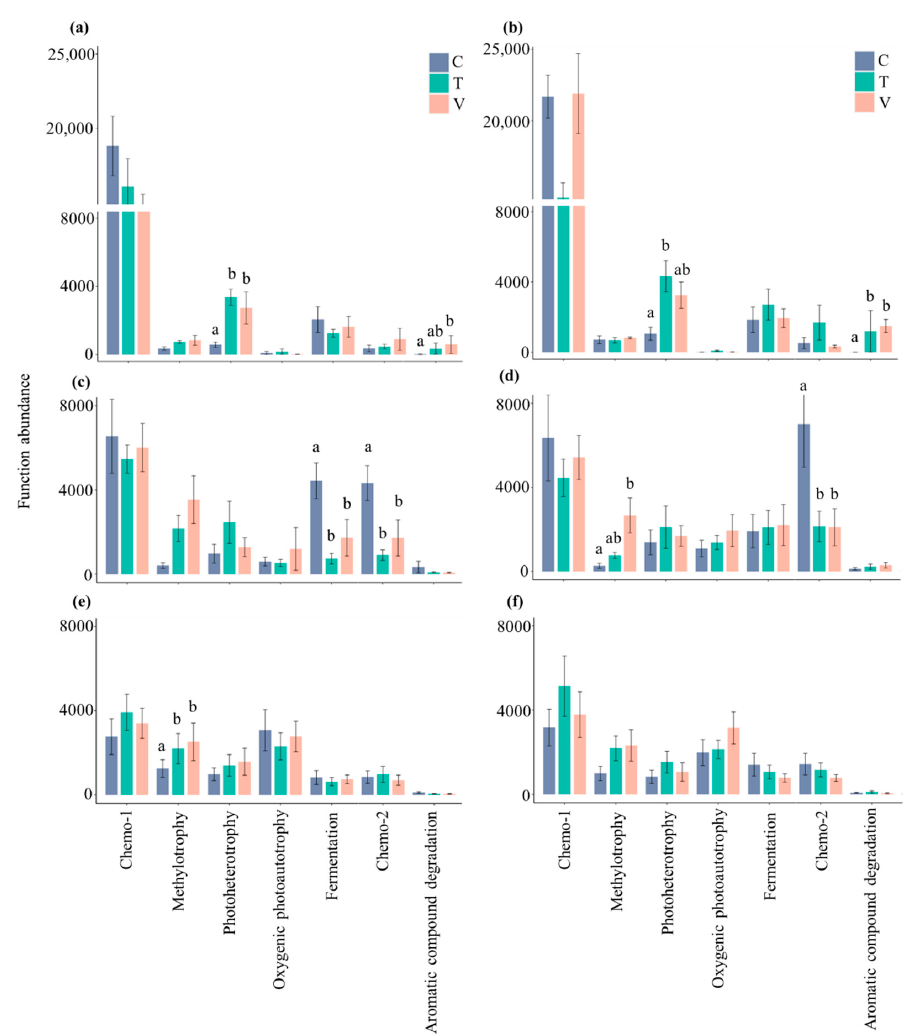
Figure 4. The columnar difference in bacterial functional groups related to the carbon cycle in leaf and stem litter. ( a ), leaf litter in spring; ( b ), stem litter in spring; ( c ), leaf litter in summer; ( d ), stem litter in summer; ( e ), leaf litter in autumn; ( f ), stem litter in autumn. All data are presented as the mean ± SE. Significant ( p < 0.05, Tukey’s test) differences among treatments are indicated by letters above the bars. The figure shows the more than 95% of the abundance of bacteria functional groups.